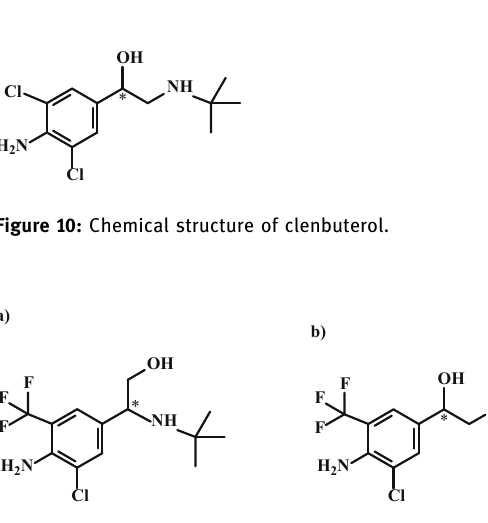
Figure 11: Chemical structures of ( a ) trantinterol and ( b ) mabuterol.